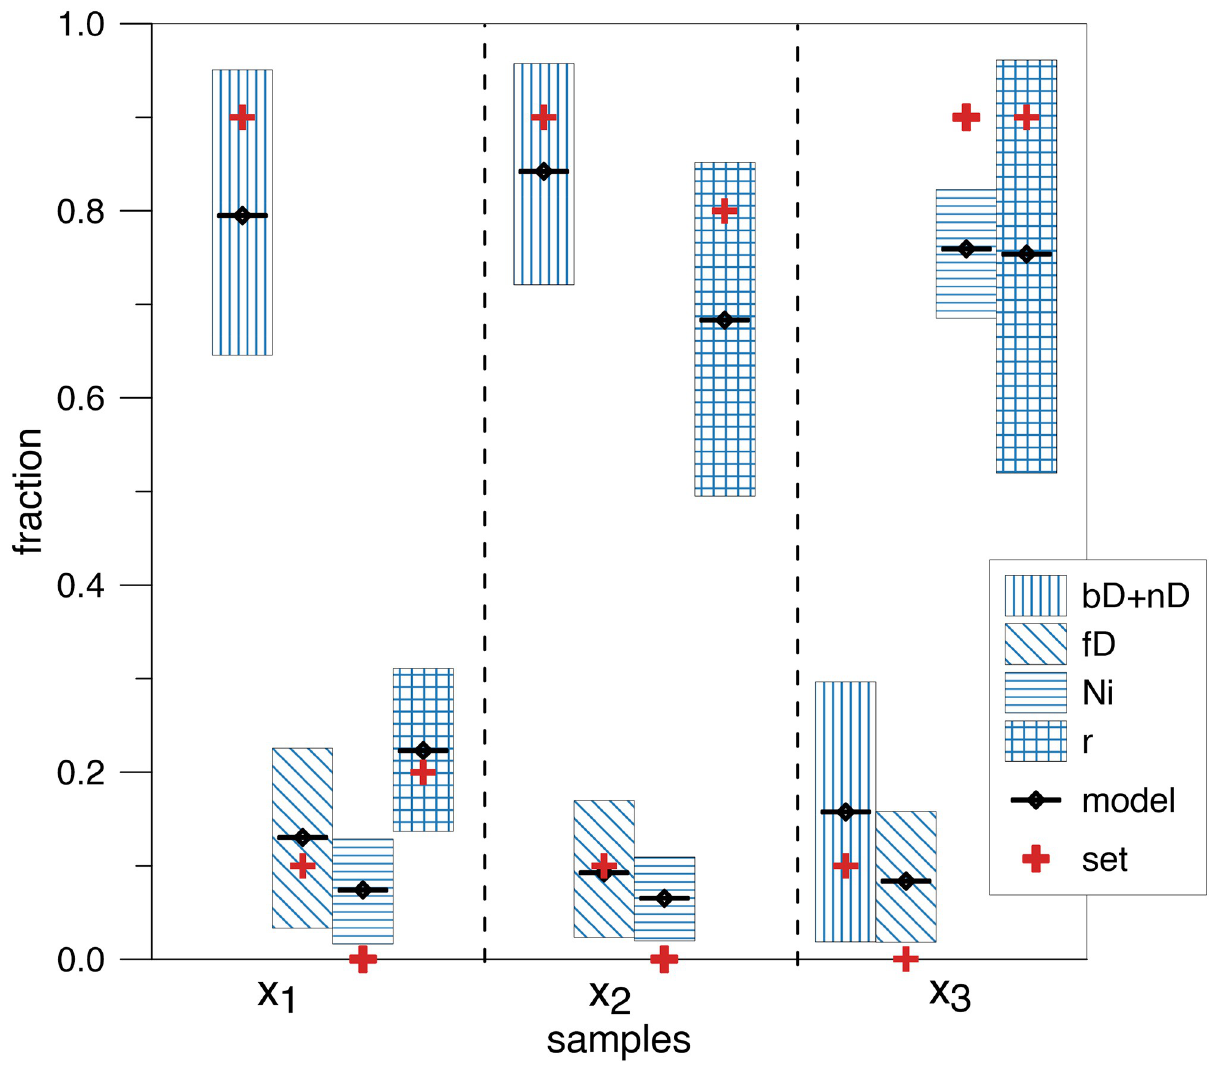
Fig 12. Comparison of model results (black symbols) with assumed values for three analysed samples (set values—Red crosses). The bars represent the 68% confidence interval for each fraction. bD and nD fractions are presented jointly due to weak isotopic separation between